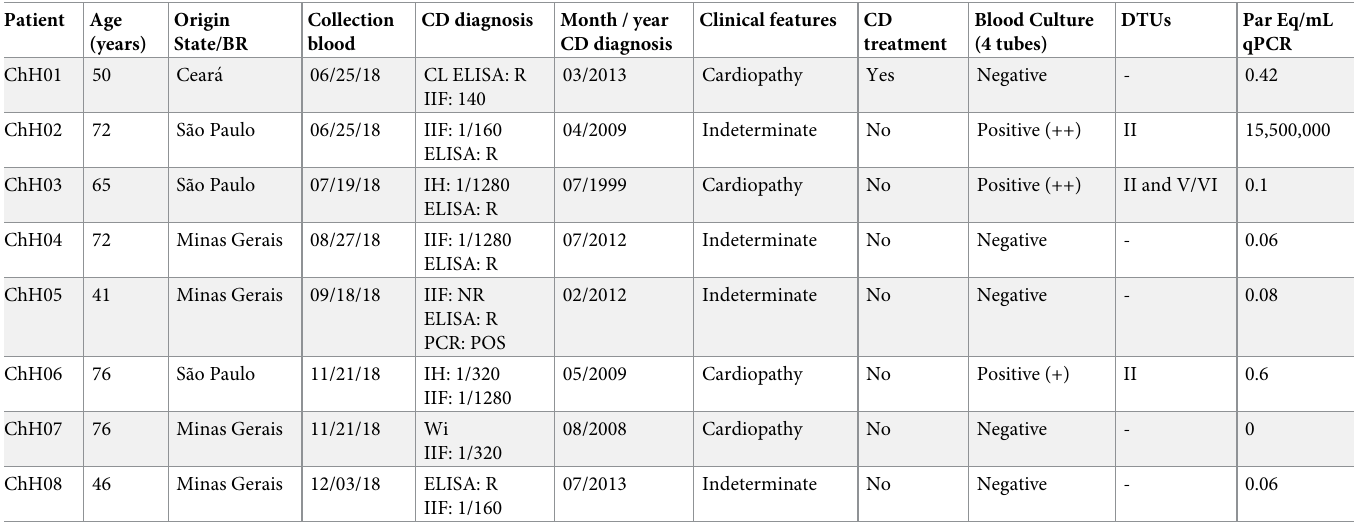
Table 1. Chagas disease dates in co-infected